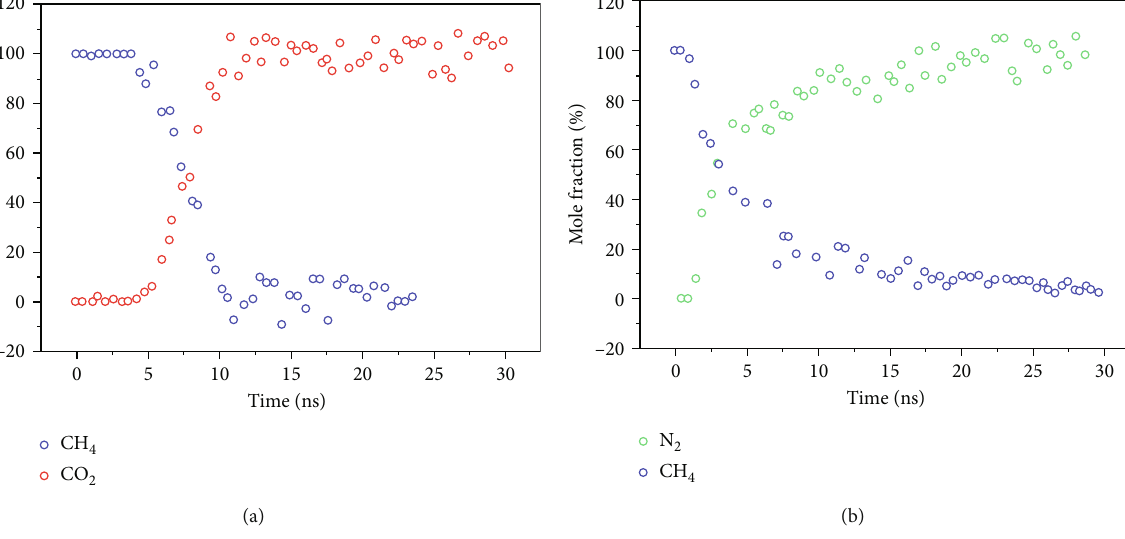
displacing CH ; (b) N 2 4 2